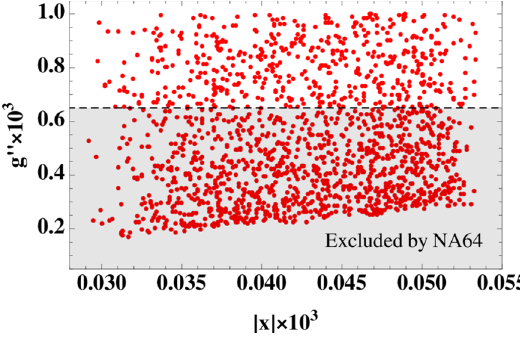
Figure 1 . Correlation between | x | and g 00 for the parameters satisfying the Atomki constraints.